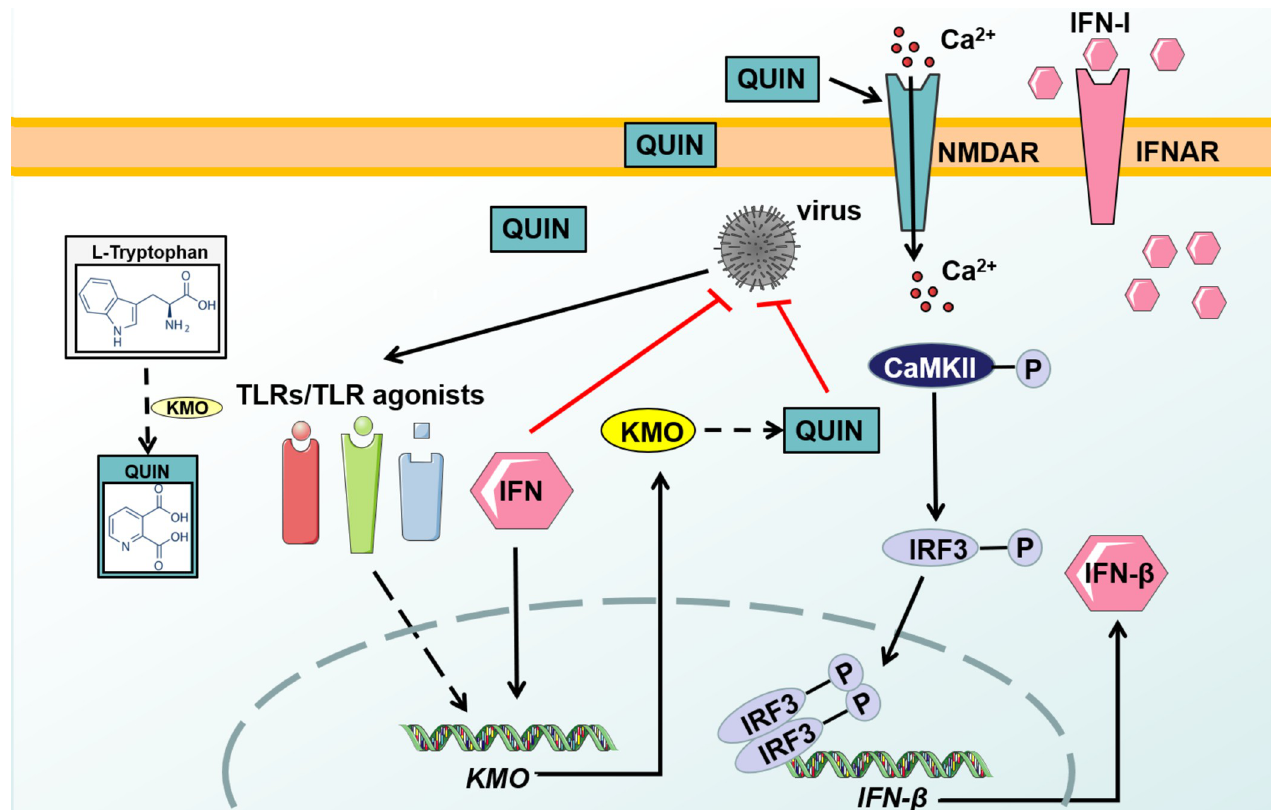
Fig 7. A schematic illustrating KMO and its enzymatic product QUIN exerted a novel broadly antiviral function. QUIN triggered the NMDAR/Ca 2+ influx and CaMKII/IRF3-mediated IFN- β production.